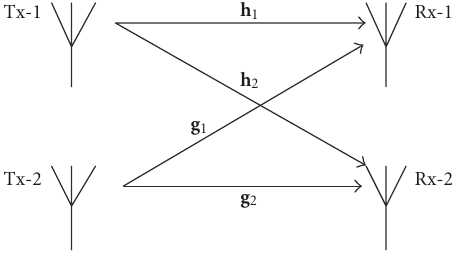
Figure 2: Two-branch transmit diversity with two receive